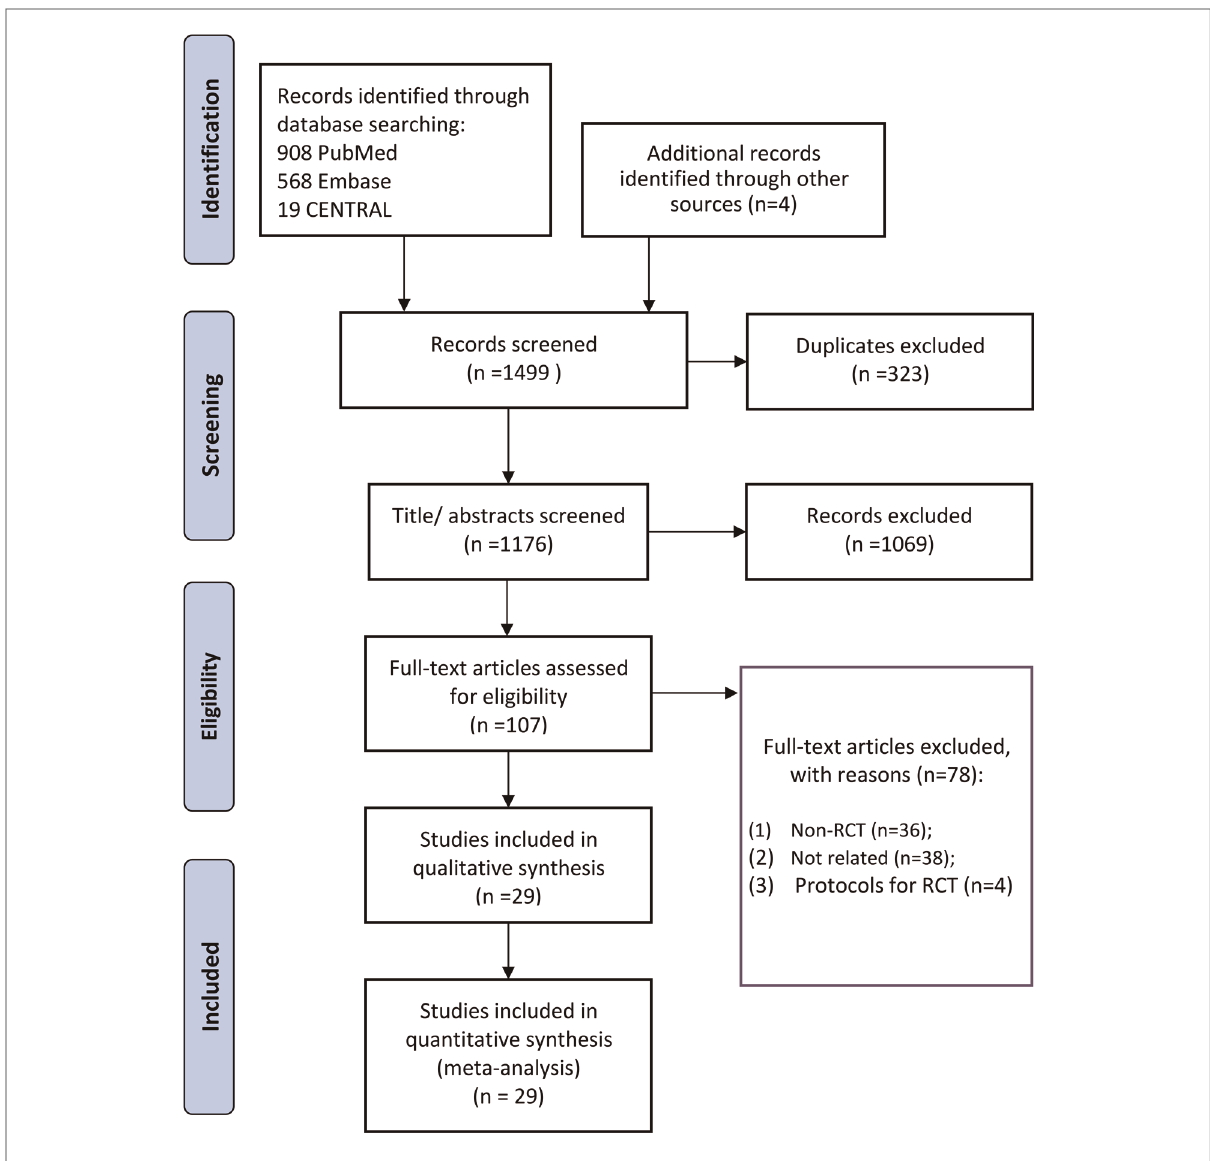
FIGURE 1 Flowchart of study searching and